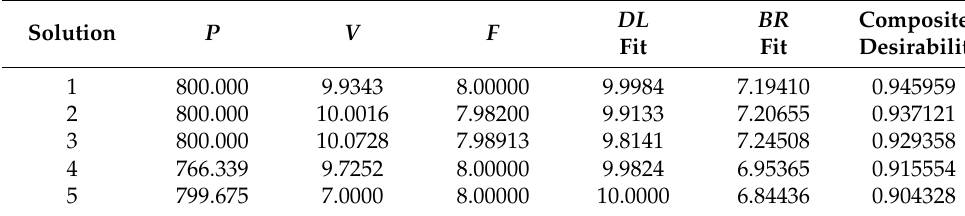
Table 7. Optimization results of the model.